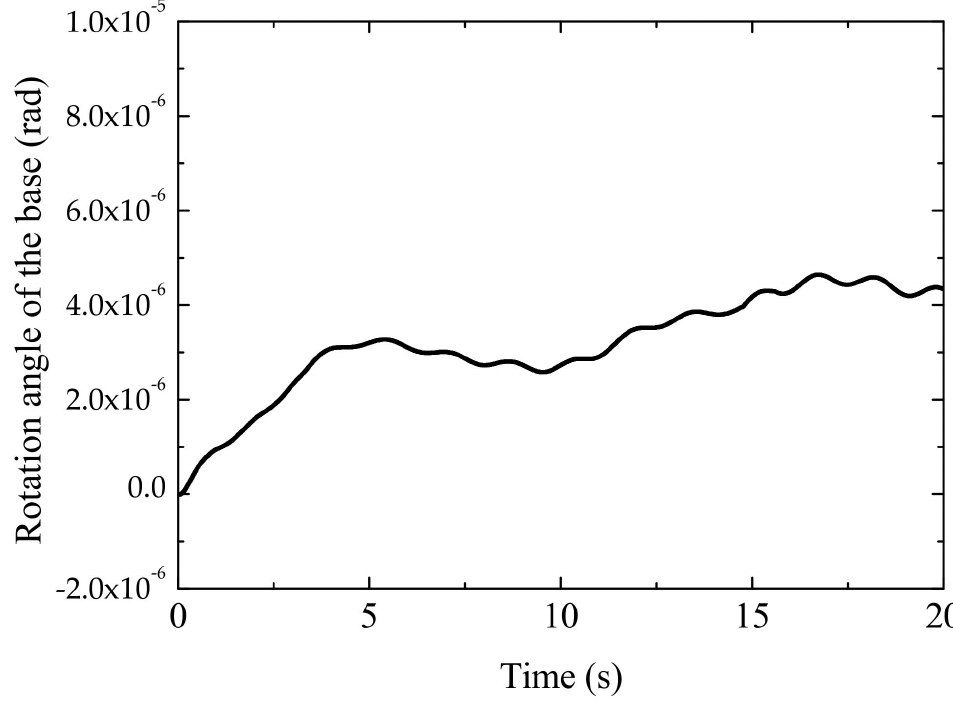
Figure 12. Rotation angle of the base in the preassembly stage.